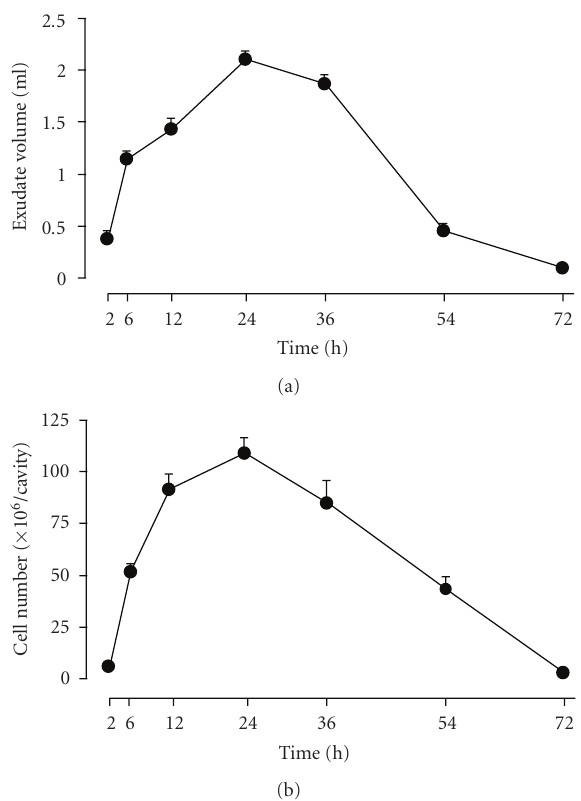
Figure 1: Time course of rat Cg pleurisy. Exudate volume (a) and leukocyte infiltration (b) were evaluated at di ff erent time points after Cg injection. The values are expressed as mean ± S.E.M. of 6 to 8